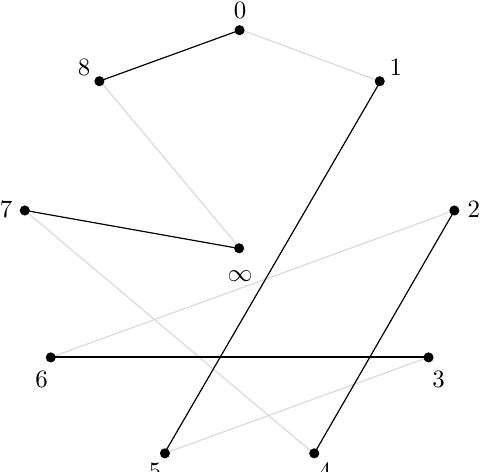
Figure 2: A graph-theoretic visualisation of constructing a round-robin tournament of order 10 from the starter s = the one-factor in grey corresponds to s + 1